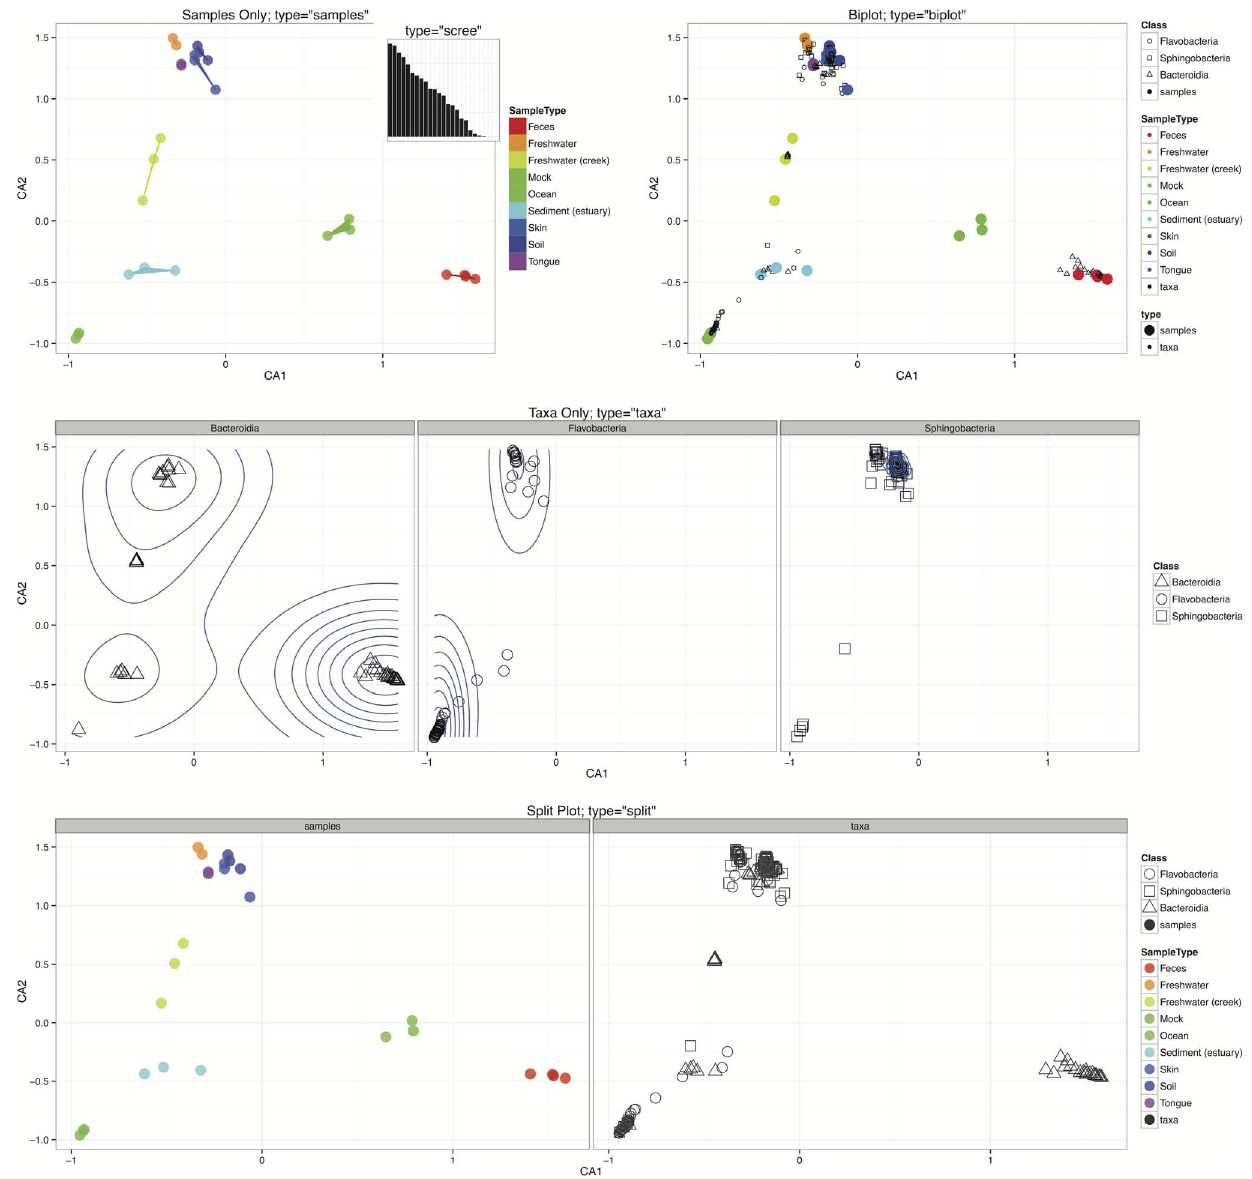
Figure 5. plot_ordination display methods included in phyloseq. Each panel uses a ‘‘Bacteroidetes-only’’ subset of the preprocessed ‘‘Global Patterns’’ dataset that was also used in Figure 4. The coordinates are derived from an unconstrained correspondence analysis [62]. Different panels illustrate different displays of the ordination results using the type argument to the plot_ordination function. (Top Left) Example of a samples-only display, with the ‘‘SampleType’’ mapped to the color aesthetic, and a filled-polygon layer to emphasize plot regions where sample types co-occur. (Top Left Insert) A ‘‘scree’’ plot of the eigenvalues associated with each axis, which indicates the proportion of total variability represented in each axis. (Top Right) Biplot representation in which samples and OTUs ordination results are overlaid. Clumps of OTUs appear to co-occur with different sample types, and some correlation with taxonomic phylum is also evident. (Middle) An OTUs-only plot that has been faceted (separated into panels) by class, with a two-dimensional density estimate overlain in blue. This view shows clearly a lack of association between the Sphingobacteria and Flavobacteria classes with fecal samples, which appear to be enriched in a subset of the Bacteroidia (relative to other OTUs in this Bacteroidetes-only dataset). Meanwhile, subsets of Bacteroidia appear to be enriched within multiple sample types. (Bottom) The ‘‘split’’ type for this graphic, in which both samples-only and OTUs-only plots are created, and shown side-by-side with one legend and shared vertical axis. Both the ‘‘biplot’’ and ‘‘split’’ options allow dual projections of both OTU- and sample-space.